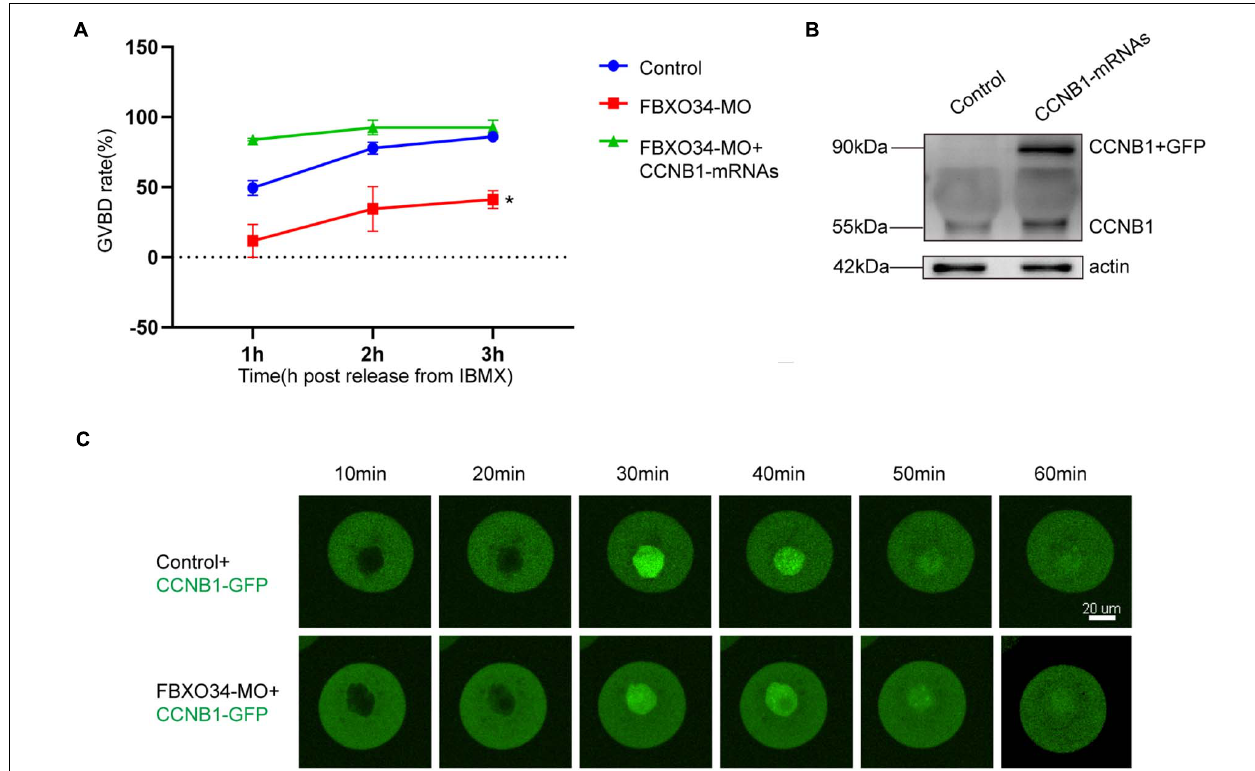
FIGURE 3 | The addition of exogenous CCNB1 alleviated the impairment caused by FBXO34-MO. (A) GVBD rates of control, FBXO34-MO group, and FBXO34-MO+CCNB1-GFP mRNA group at 1, 2, and 3 h following release from IBMX. (B) Western blot of the CCNB1-GFP, endogenous CCNB1, and actin in the control group and the CCNB1-GFP mRNA group were presented (180 oocytes per sample). (C) The dynamics of CCNB1-GFP were shown by live-cell imaging in control oocytes and FBXO34-MO oocytes. Images of live cells were taken every 10 min from releasing to occurrence of GVBD. Scale bar, 20 µ m. Quantitative data were obtained from at least three independent repeats, and one repeat of each experiment contained at least 50 oocytes. The error bars of quantitative data represent the standard deviation (* P <